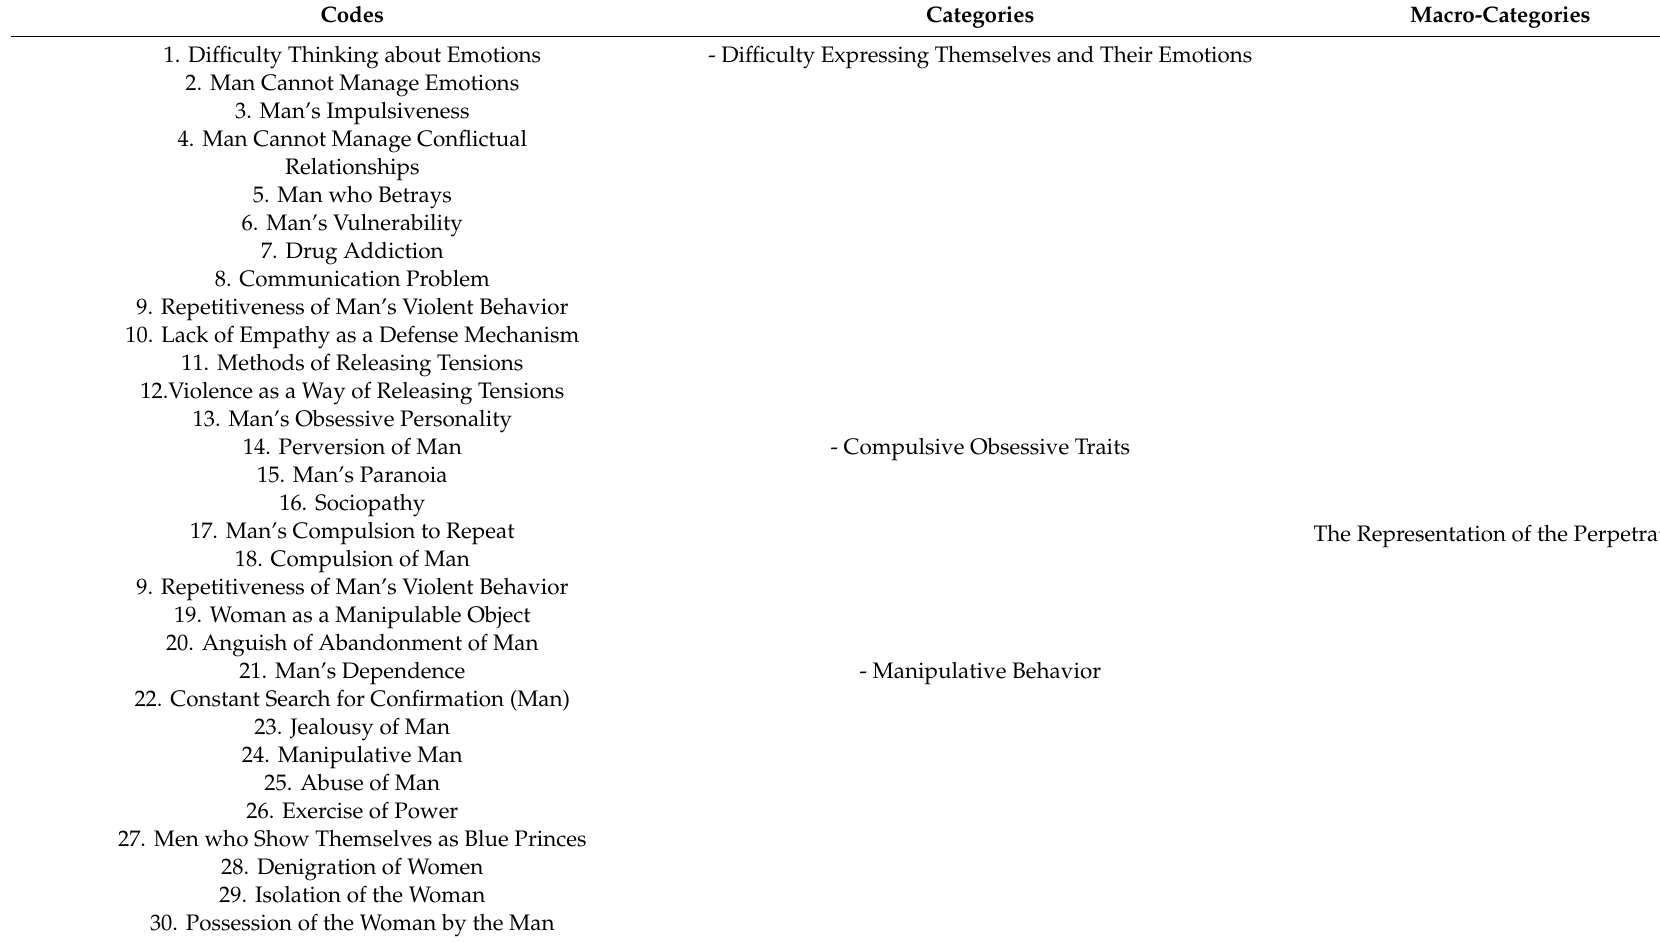
Table 2. Table illustrates all the codes selected in the study, with their respective categories and macro-categories.